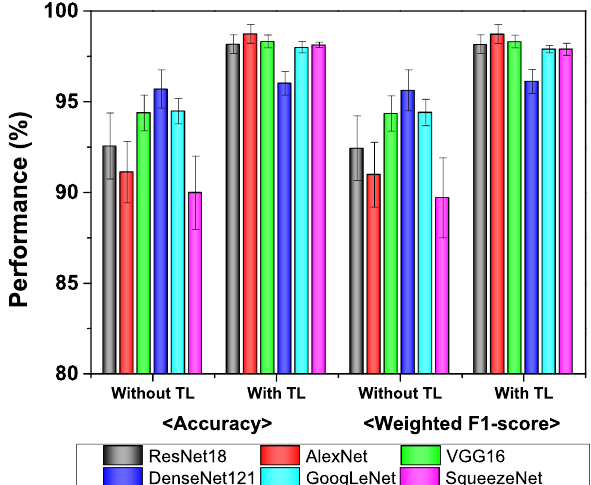
Figure 3. The graph representation of classification performance (mean) for each model without TL and that with TL. Error bars represent standard deviation